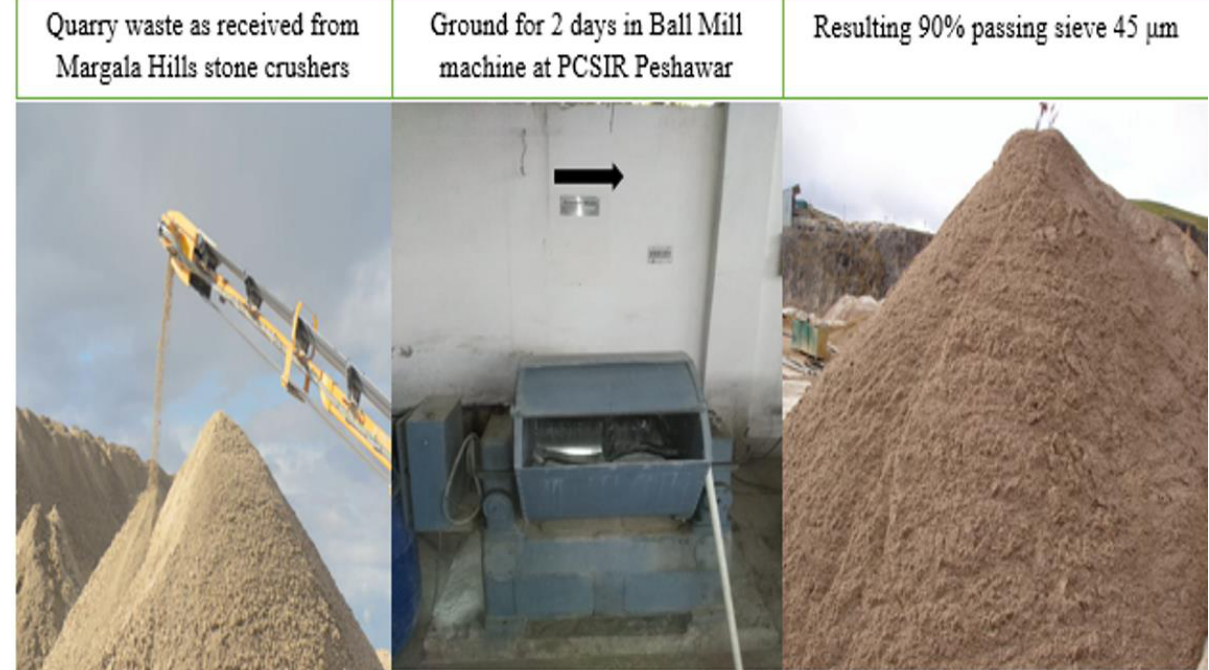
Figure 1. The grinding process of QRD waste.